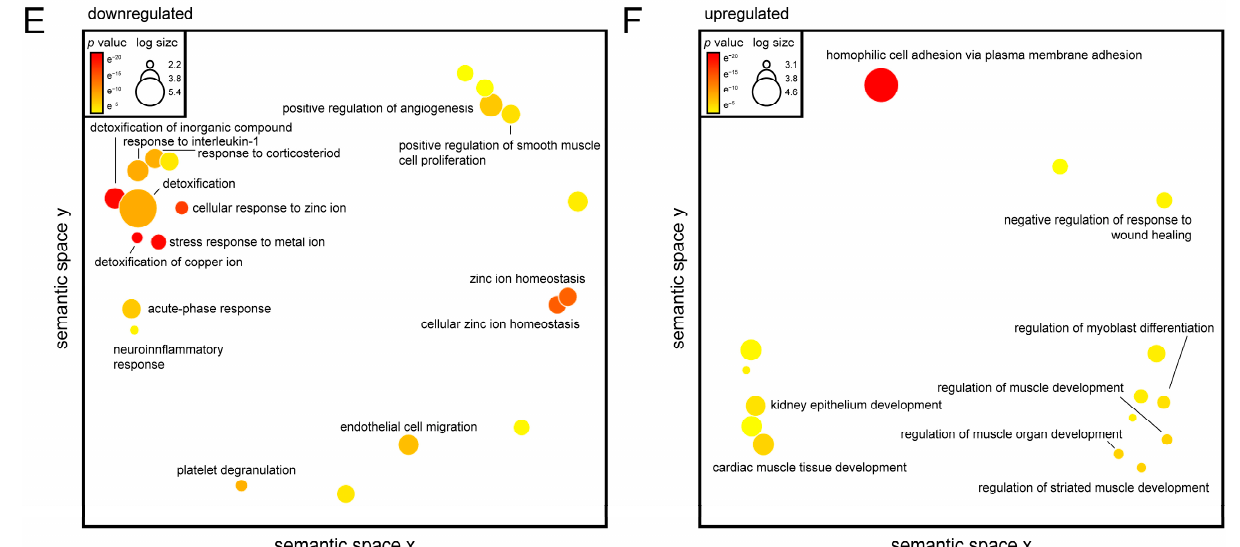
Figure 2. Gene expression signatures of hypertrophic myocardium of iPAH patients before LuTX and reverse remodeled hearts 3 months after surgery. ( A ) PCA of samples before PEA and 3 months after PEA. Each dot represents one donor; colors indicate time points. ( B ) Volcano plot depicting DEGs as a function of fold change and statistical significance. Each dot represents one gene. Red and green indicate up- and downregulated genes, respectively. Insert shows absolute numbers of DEGs when comparing before surgery and after recovery. Red and green bars indicate up- and downregulated genes, respectively. ( C ) Heatmap of DEGs. Each row represents one donor at a certain time point; each line indicates one gene. Red and blue indicate up- and downregulation, respectively. ( D ) Heatmaps of down- (green) and upregulated genes (red) are shown. Colors indicate absolute, average log 2 -transformed expression values. Gene ontologies associated with ( E ) down- and ( F ) upregulated DEGs. Each circle represents one ontology. Colors indicate p